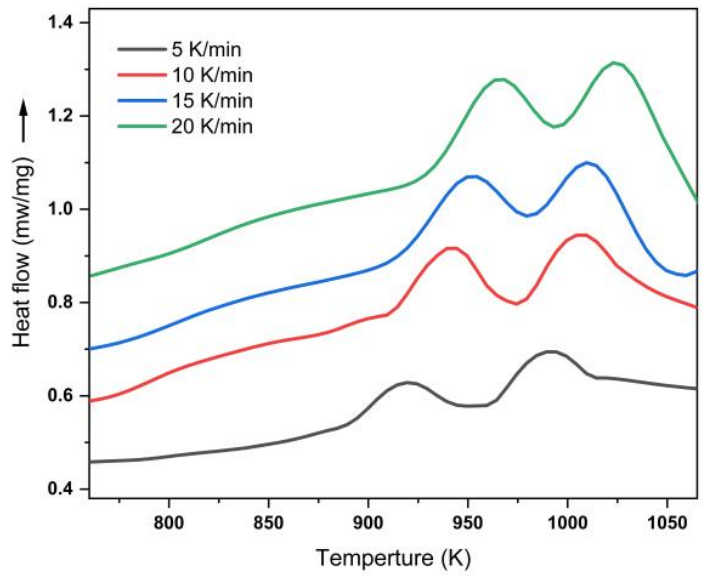
Figure 1. DSC curves of Li 2 O–Al 2 O 3 –SiO 2 glass samples at different heating rates. Table 1. Characteristic temperatures measured using non-isothermal differential scanning calorim- etry. The First Crystallization Peak The Second Crystallization Peak